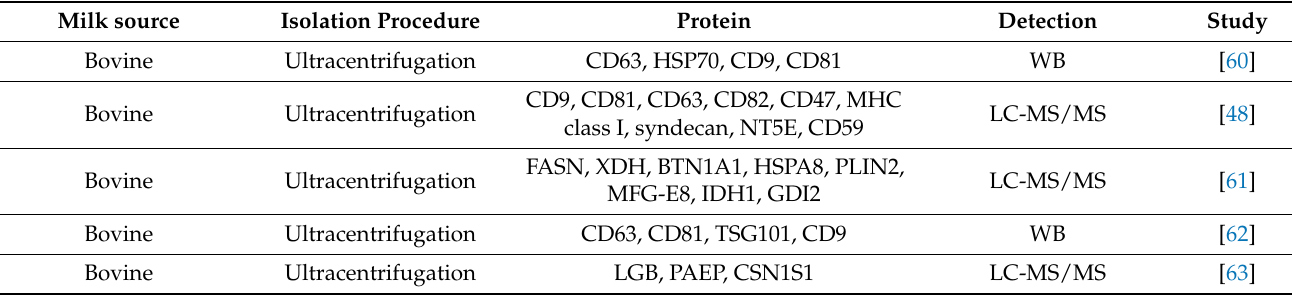
Table 3. Main proteins identified in isolated extracellular vesicles from livestock